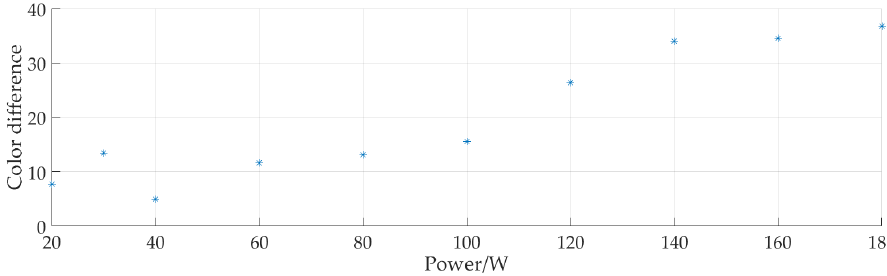
Figure 11. The relationship curve between the color difference and the laser power.